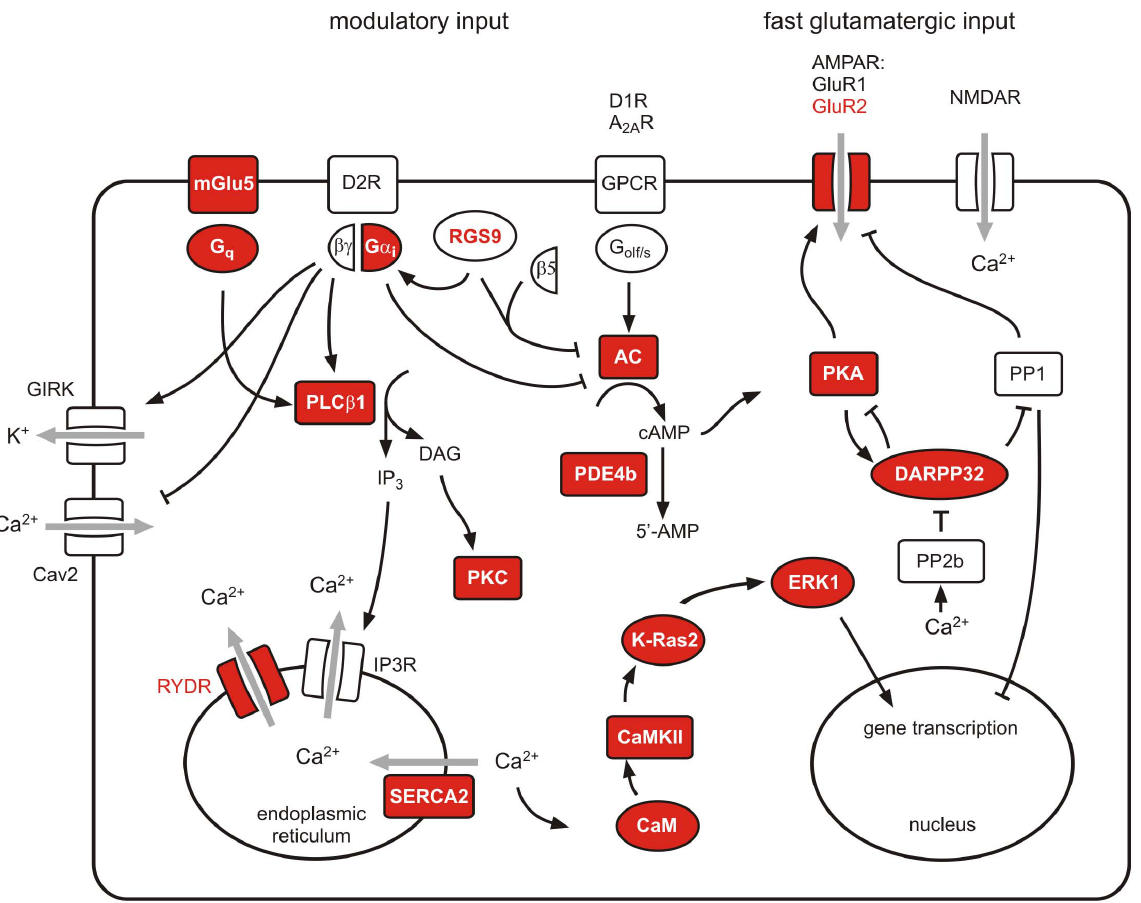
Figure 1. Intracellular localization and functional interaction of selected signaling components expressed in striatum. Transcripts of signaling components that are significantly downregulated in striata of RGS9-deficient mice are shown in red. The full notations of the transcripts are given in Table 1 and Table S4 (in File S1).